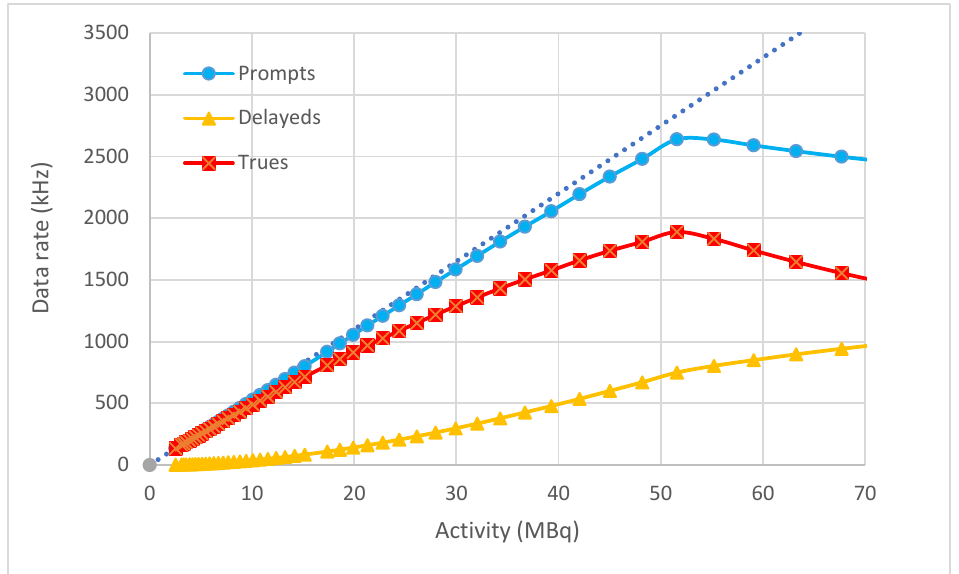
Figure 7. Data rates measured from MicroPEPT for a central 11 C source of varying activity. The upper set of points shows the total coincidence rate, the lower set the delayed coincidence rate, and the middle set the rate of true coincidences given by the difference prompt delayed. The dotted line corresponds to a sensitivity of 5.4%.